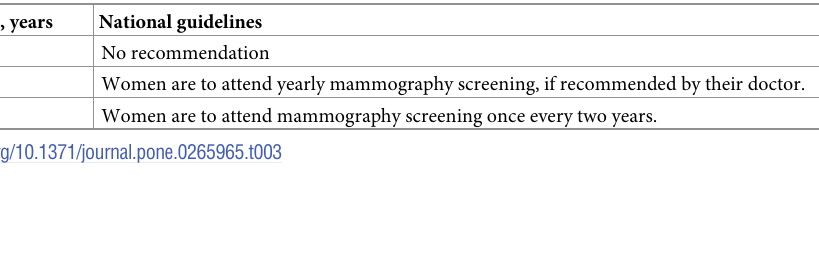
Table 3. National guidelines for breast cancer screening in